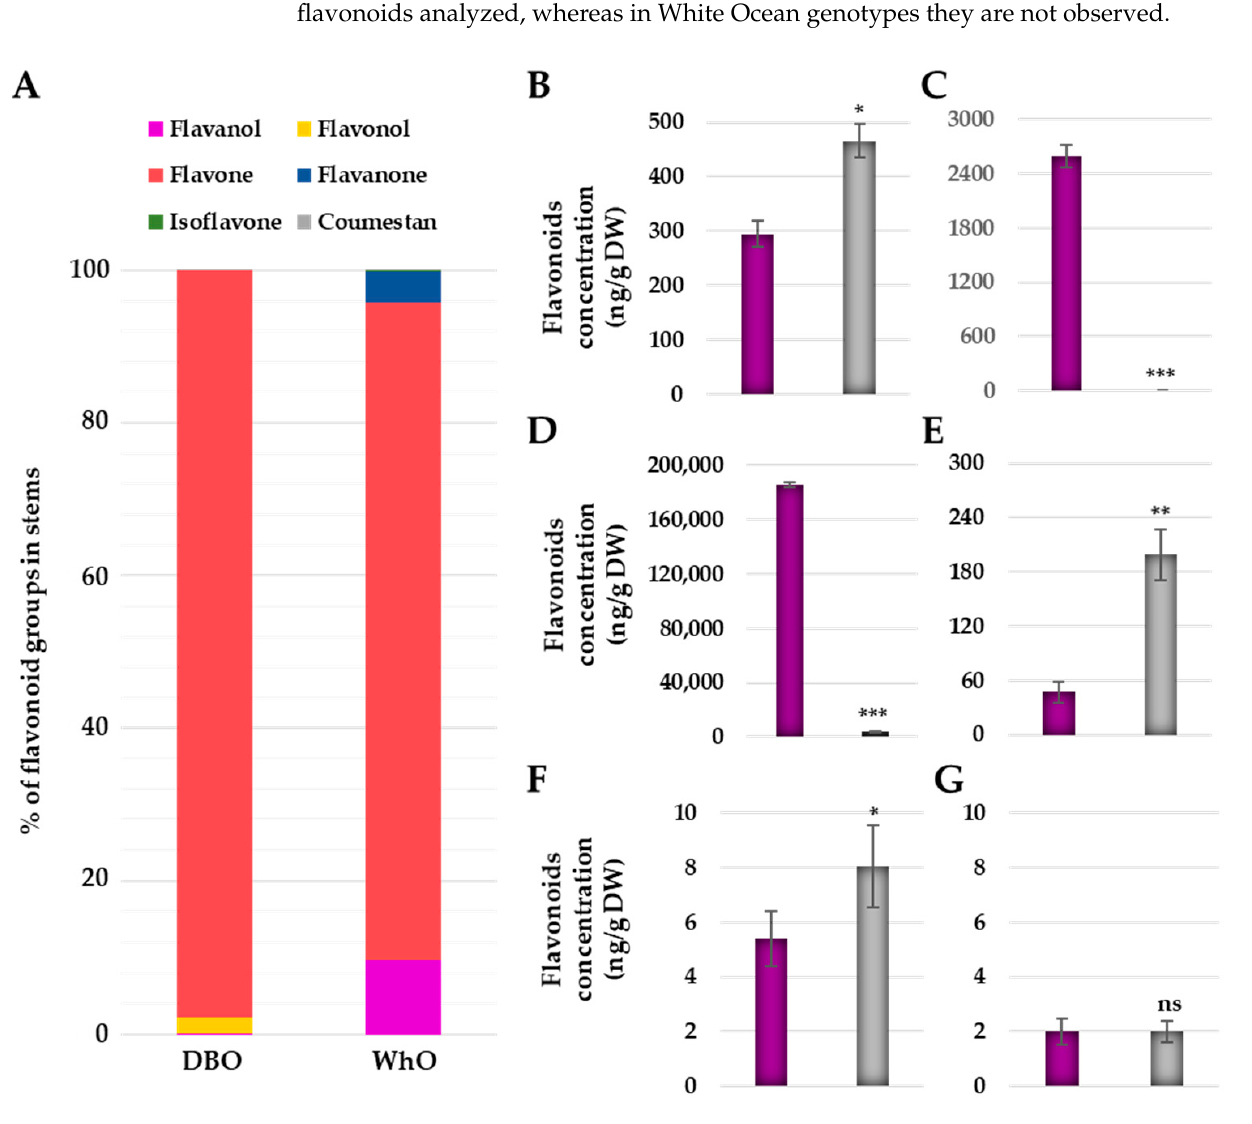
Figure 4. Flavonoid groups accumulated in stems of Deep Blue Ocean (DBO) and White Ocean (WhO) Campanula portenschlagiana genotypes. ( A ) Percentage of flavonoid groups in DBO and WhO. Concentrations (ng per g dry weight) of ( B ) flavanols, ( C ) flavonols, ( D ) flavone, ( E ) flavanones, ( F ) isoflavones, and ( G ) coumestan in stems of DBO (dark purple column) and WhO (light gray column) genotypes. t -test significance: * p < 0.05, ** p < 0.01, *** p < 0.001, ns = no significance; n = 5.